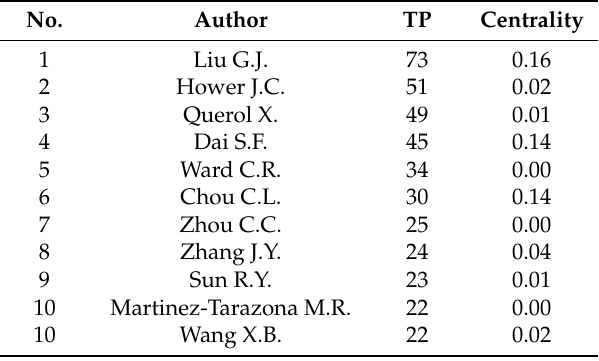
Table 1. Information of productive authors of trace elements in coal and ash.